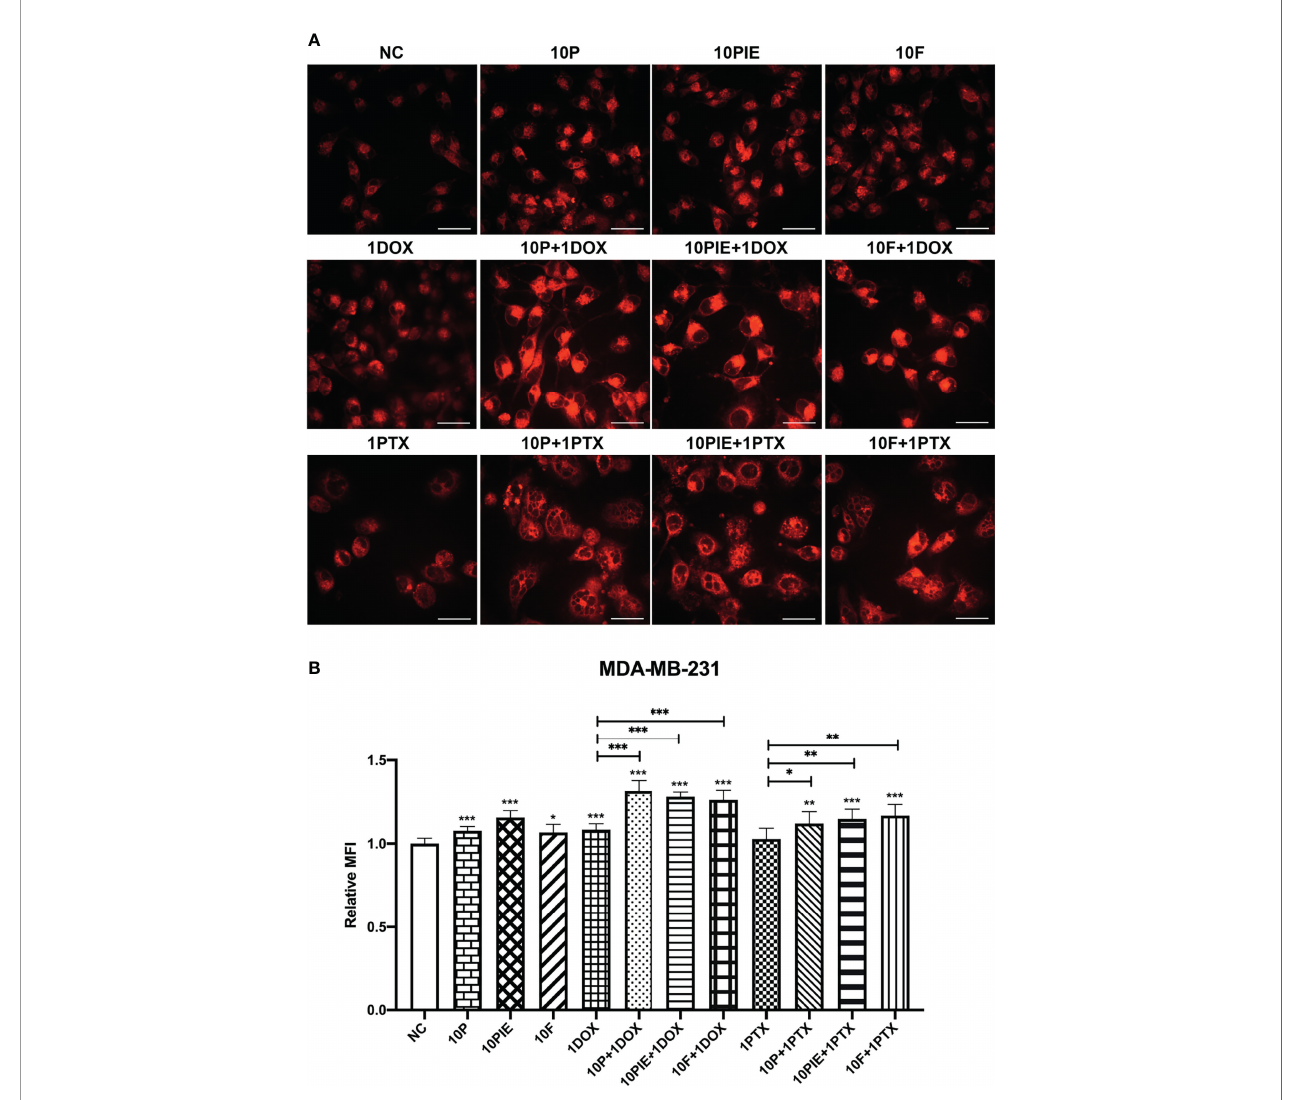
FIGURE 5 | Intracellular iron levels of MDA-MB-231 cells treated with propofol/PIE/fospropofol disodium with or without doxorubicin/paclitaxel. (A) Intracellular ferrous ion levels in MDA-MB-231 cells treated with different drugs were determined using laser scanning confocal microscopy. Bar = 34 µm. (B) Statistical analysis of relative MFI of intracellular ferrous ions in MDA-MB-231 cells under different treatments. * P < 0.05, ** P < 0.01, *** P <